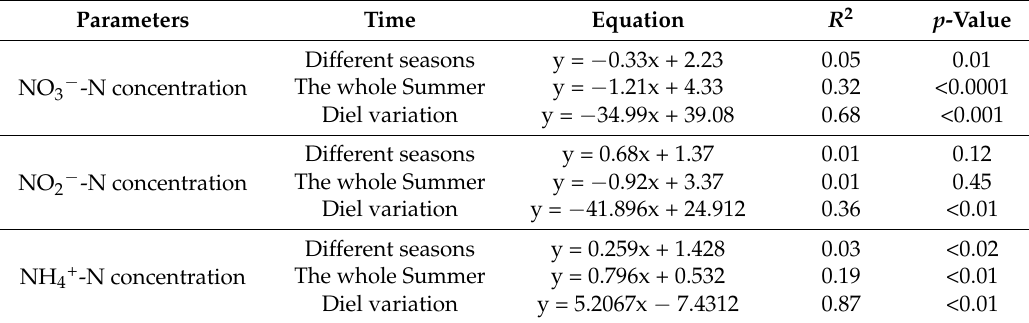
Table 4. Fitting equations of different environmental factors and methane flux during different seasons and the correlation coefficient ( R 2 ) and probability test value ( p -value). Parameters Time Equation R 2 Different NO 3 − -N concentration